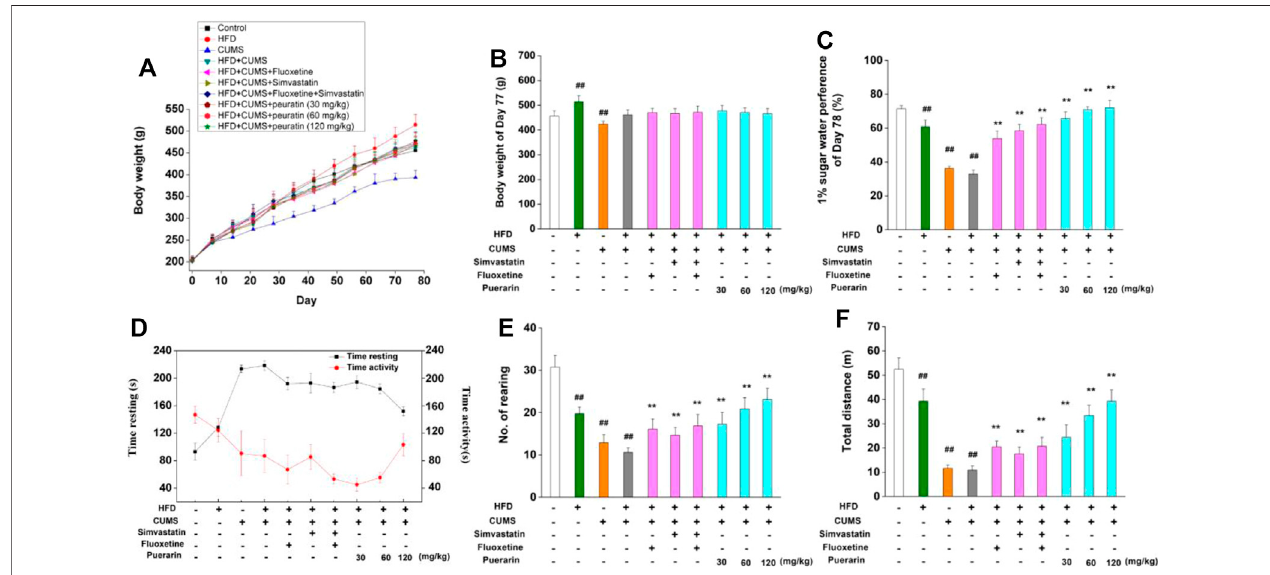
FIGURE 2| Effect ofpuerarin on body weight,sucrose preference, and depression-likebehavior. (A) Body weight ofall rats was recorded at days 0, 7, 14, 21, 28, 35, 42, 49, 56, 63, 70, and 77. (B) Body weight at the 77 th day was statistically analyzed. (C) Water and sucrose solution consumption at the 78 th day were carried out, and the sucrose preference rate was calculated. The time resting or activity (D) , rearing numbers (E) , and total distance (F) traveled during the last 4 min were recorded and statistically analyzed. Values are expressed as mean ± S.E.M ( n (cid:2) 8). ## p < 0.01 vs. the normal control group; ** p < 0.01 vs. the HFD/CUMS group.